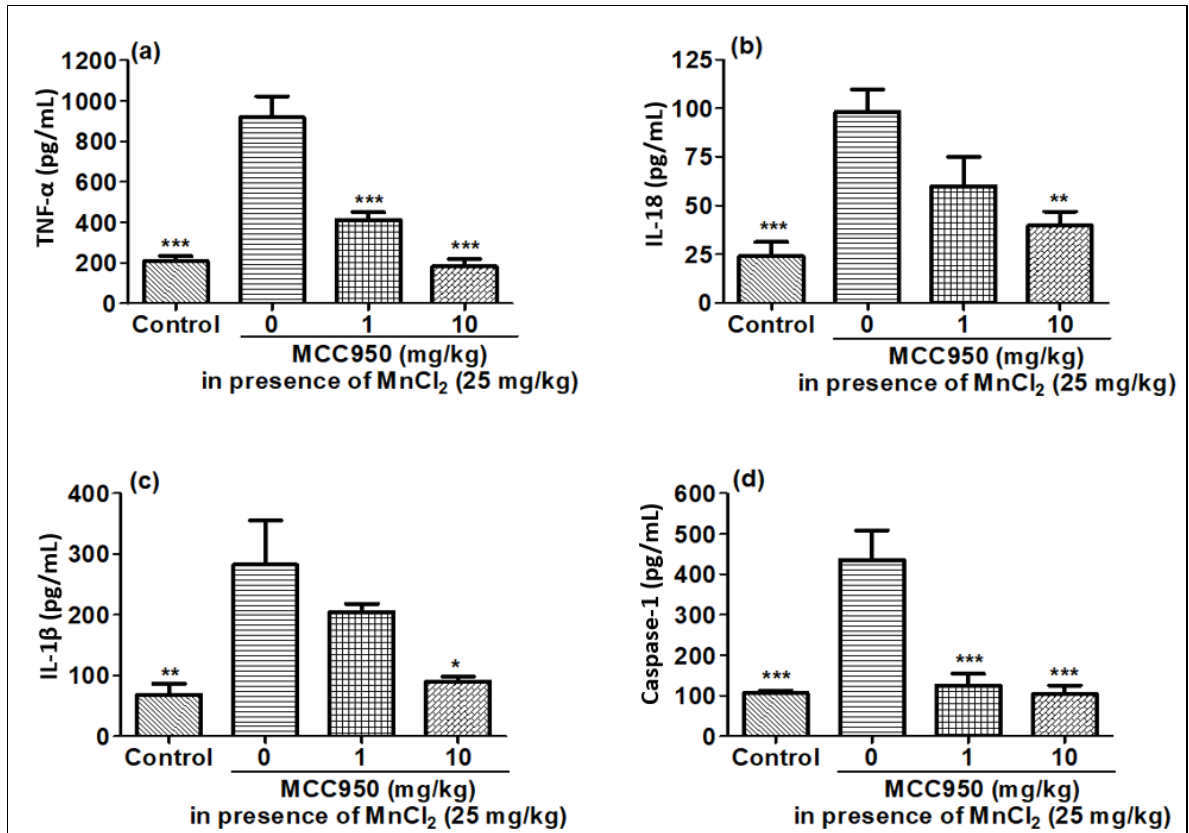
Figure 11. MnCl 2 exposure elevated pro-inflammatory cytokines, and MCC950 inhibited cytokines in rat brain samples detected by ELISA. ( a ) TNFα , ( b ) IL-18, ( c ) IL- 1β , ( d ) caspase-1. Data represented as mean ± SEM. * p < 0.05, ** p < 0.001, *** p < 0.0001 vs. disease control group.